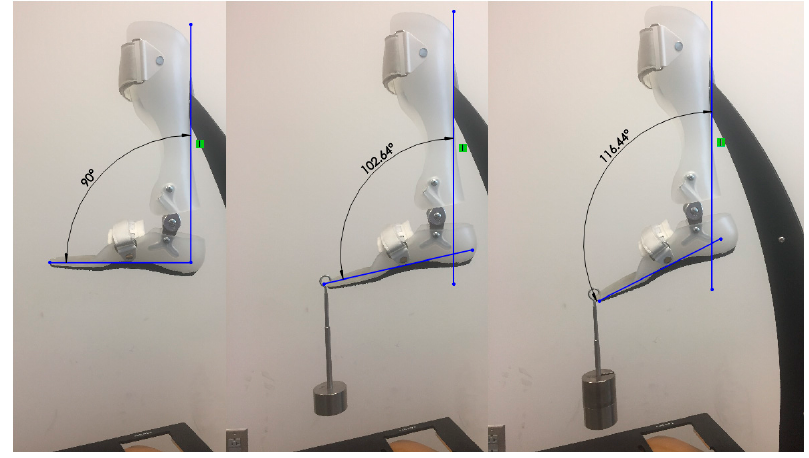
Figure 7. Experimental setup to define the changes in the motion of the HAFO by applying force.